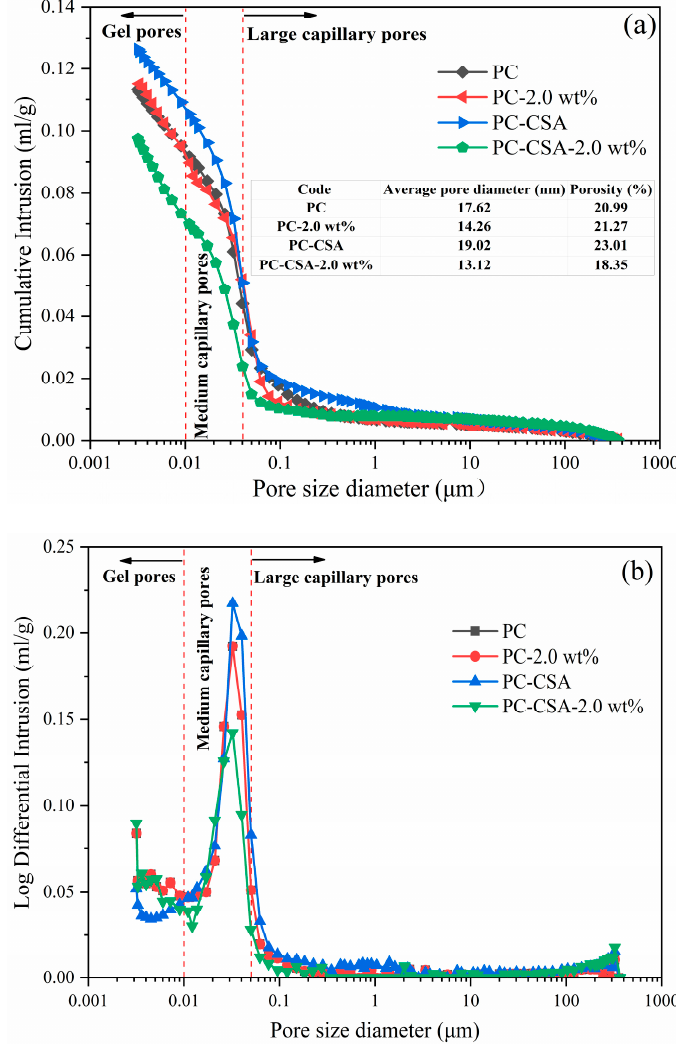
Figure 12. The pore structure of cement at 3 d curing: ( a ) cumulative intrusion; ( b ) differential intrusion.